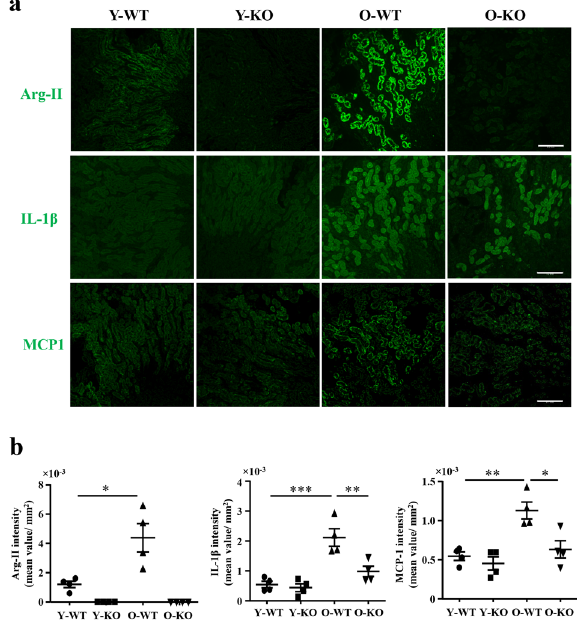
Fig. 4 Arg-II de fi ciency reduces age-associated IL-1 β and MCP1 in the mouse kidney. Renal paraf fi n sections (one section from each animal) were prepared from young and old wild type (WT) and arg- II − / − female mice ( n = 4 in each group) and subjected to immuno fl uorescence staining of a Arg-II, IL-1 β and MCP1, respec- tively. Representative images were selected from the outer medulla. Scale bars = 0.2 mm. b Quanti fi cation of the intensity of fl uores- cence signals from the whole renal section area was performed